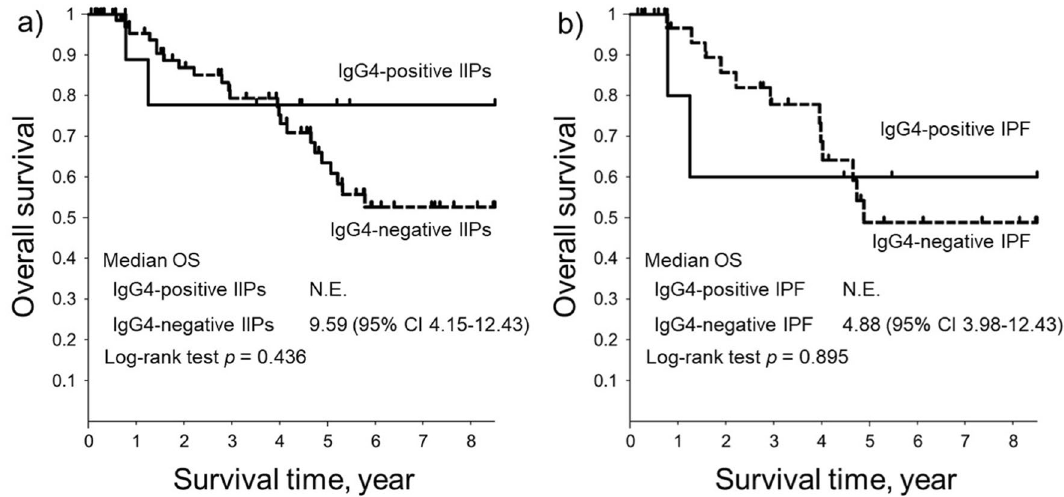
Figure 1. Survival curves of patients with either IIPs or IPF with or without IgG4-positive cell infiltration. ( a ) The Kaplan–Meier curve of the overall survival of patients with idiopathic interstitial pneumonias with or without IgG4-positive cell infiltration in the lungs (IgG4-positive or negative IIPs). (Solid line: IgG4- positive IIPs, Broken line: IgG4-negative IIPs). ( b ) The Kaplan–Meier curve of the overall survival of patients with idiopathic pulmonary fibrosis with or without IgG4-positive cell infiltration in the lungs (IgG4-positive or negative IPF). (Solid line: IgG4-positive IPF, Broken line: IgG4-negative IPF). CI confidence interval, Ig immunoglobulin, IIP idiopathic interstitial pneumonia, IPF idiopathic pulmonary fibrosis, N.E. not evaluable, OS overall